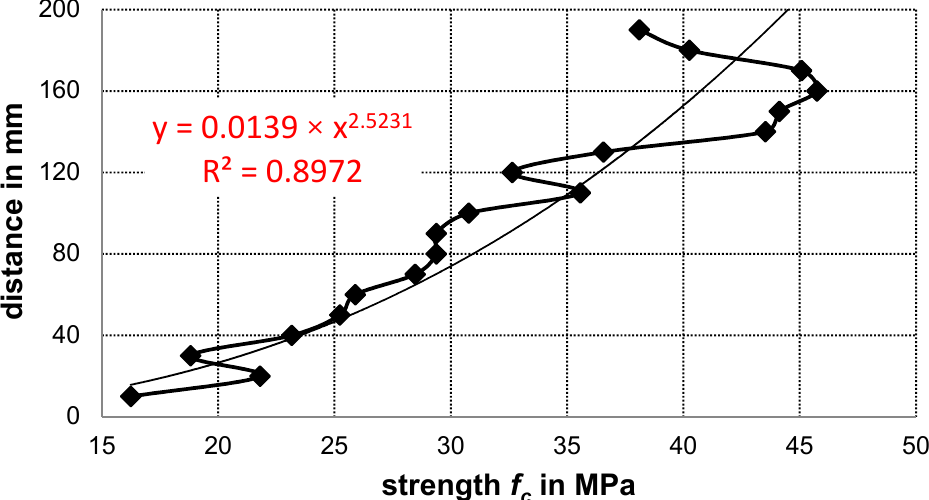
Figure 10. Compressive strength distribution in the sample taken from the slab heavily loaded with the fire (sample no. 008).